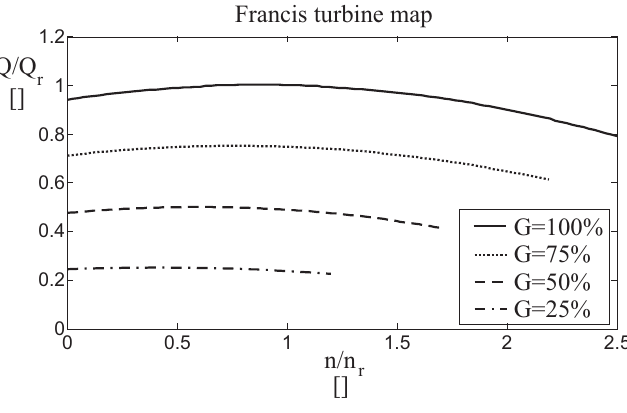
Figure 4. Francis turbine map for different values of G